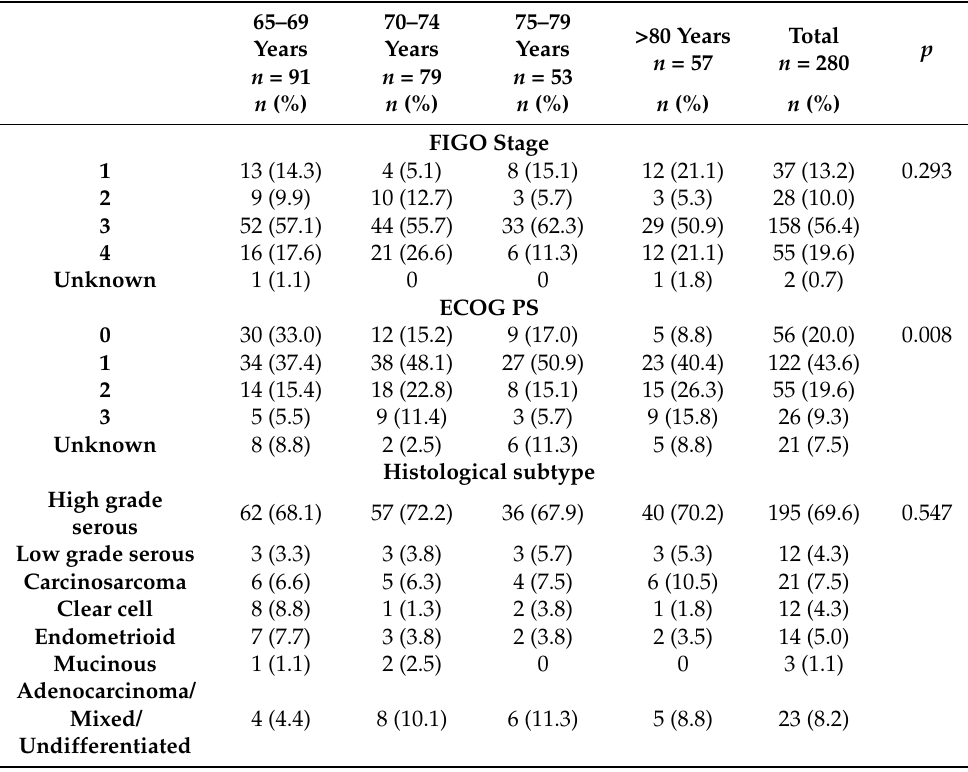
Table 1. Patient characteristics: stage and ECOG performance status at